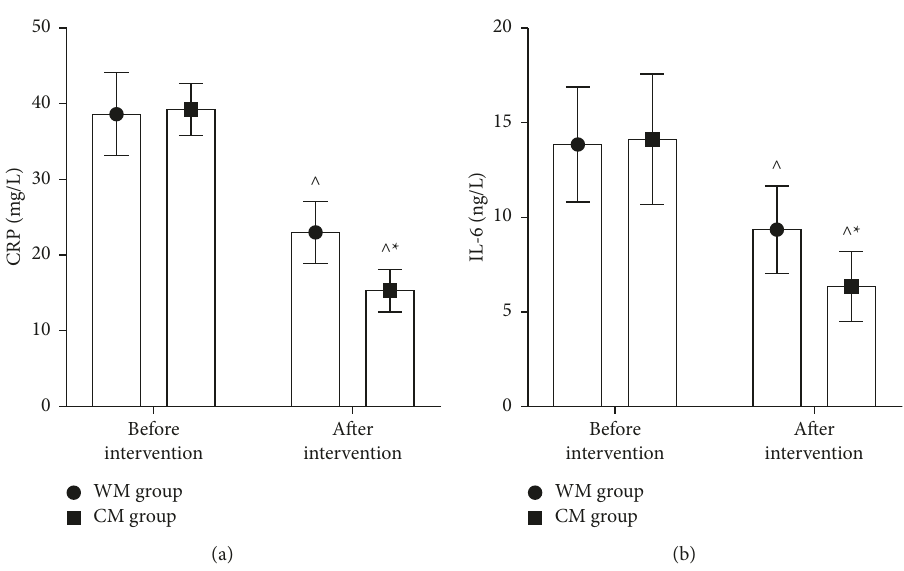
Figure 4: Comparison of CRP and IL-6 levels in both groups. (a) CRP levels. (b) IL-6 levels. Compared with the same group before intervention,